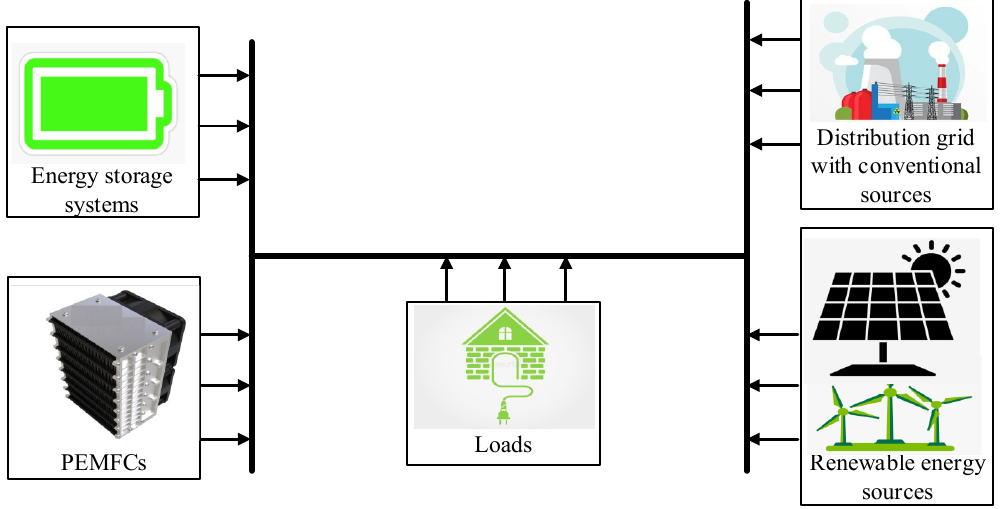
Figure 1. Overview of the green building structure with